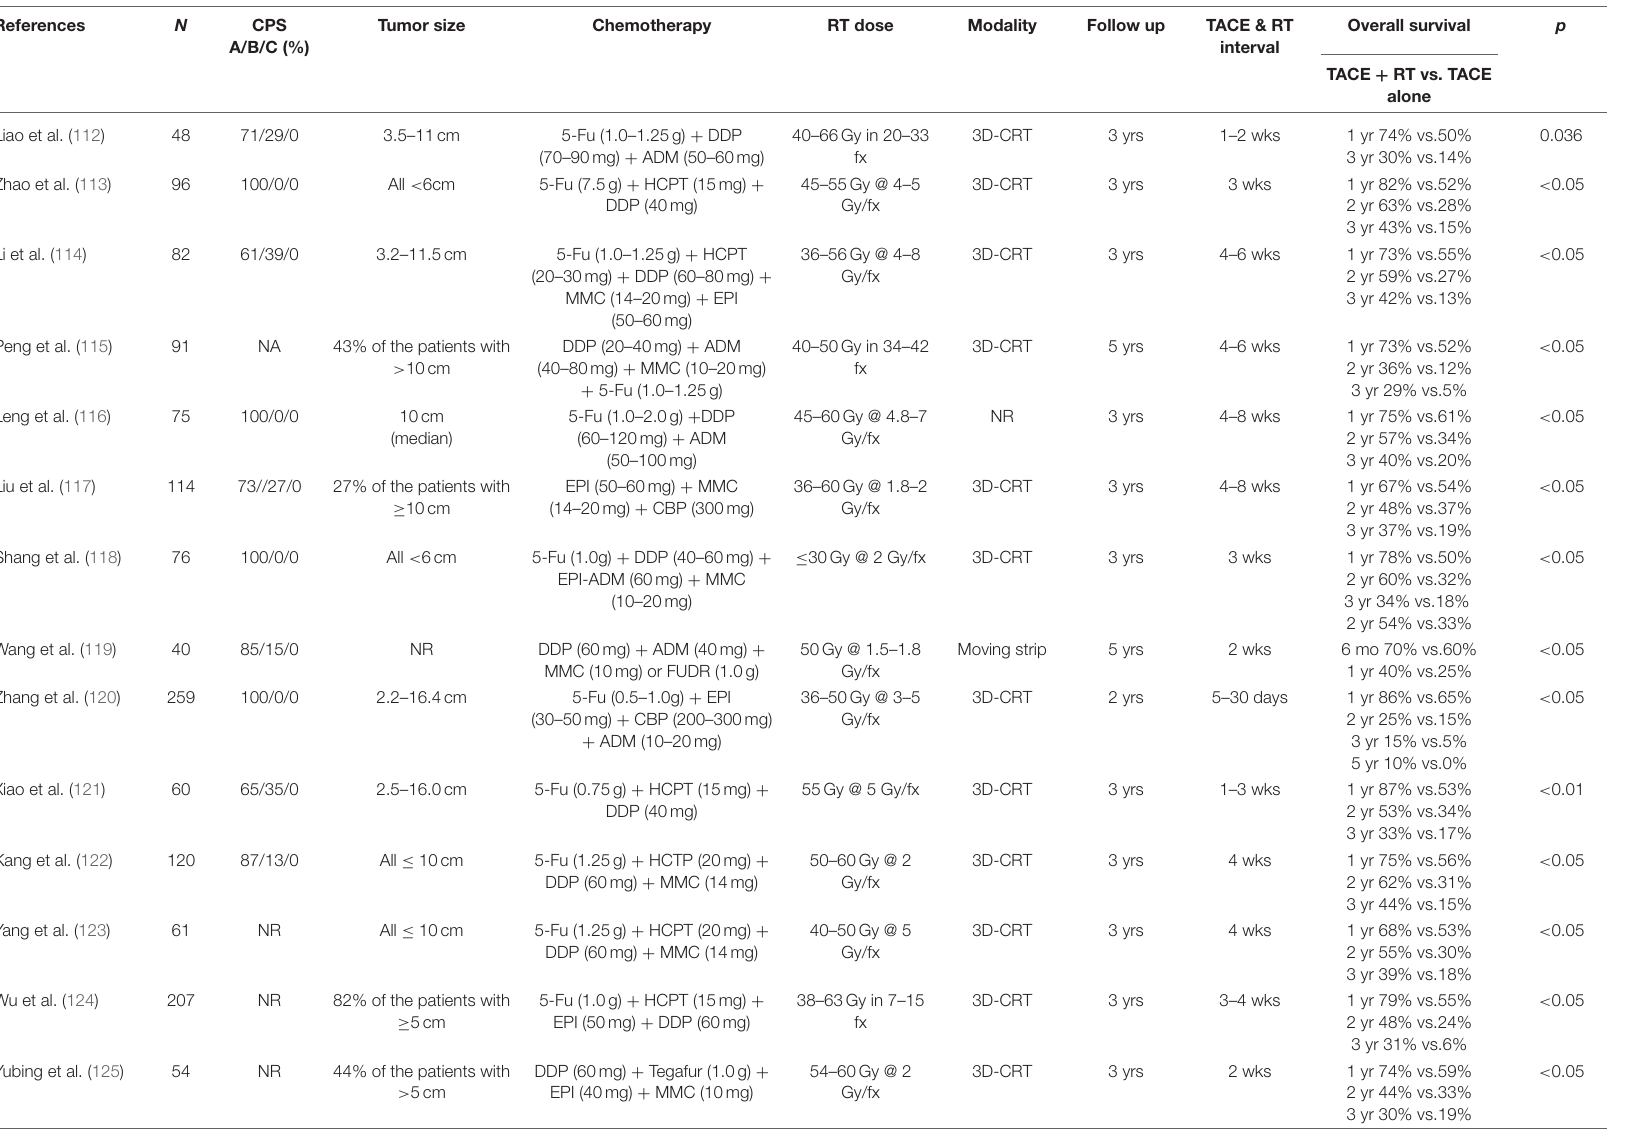
TABLE 7 | Prospective studies comparing transcatheter arterial chemoembolization plus radiation therapy with transcatheter arterial chemoembolization alone for hepatocellular